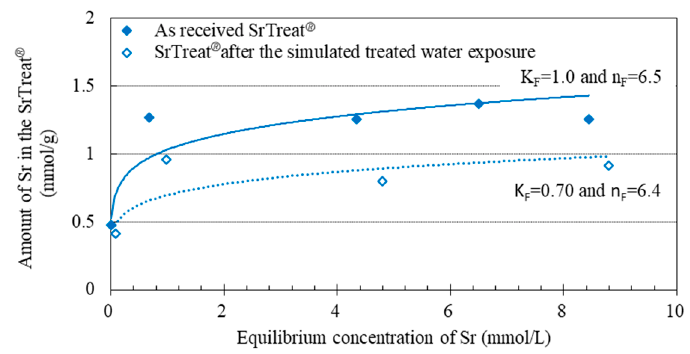
Figure 6. Amount of Sr in the SrTreat ® before and after the simulated treated water exposure at pH = 12 and a fit according to Freundlich exponential law.